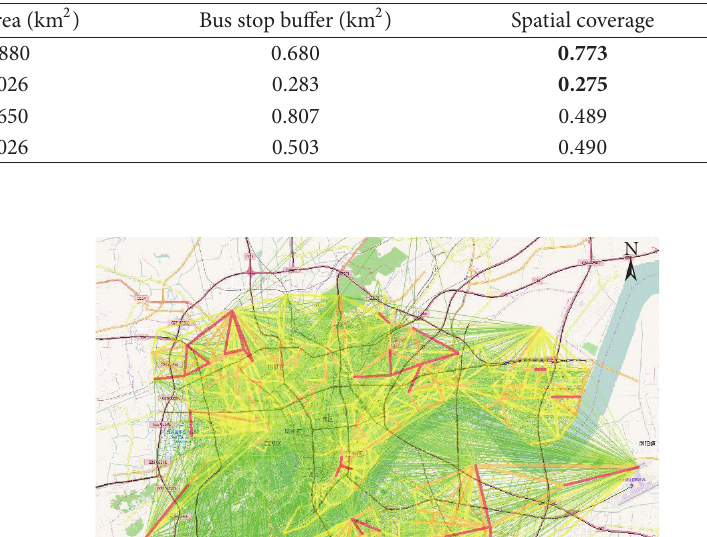
Table 5: Zonal data of spatial coverage and TCI.